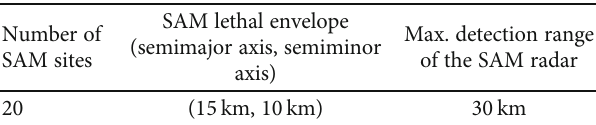
Table 3: Threat model